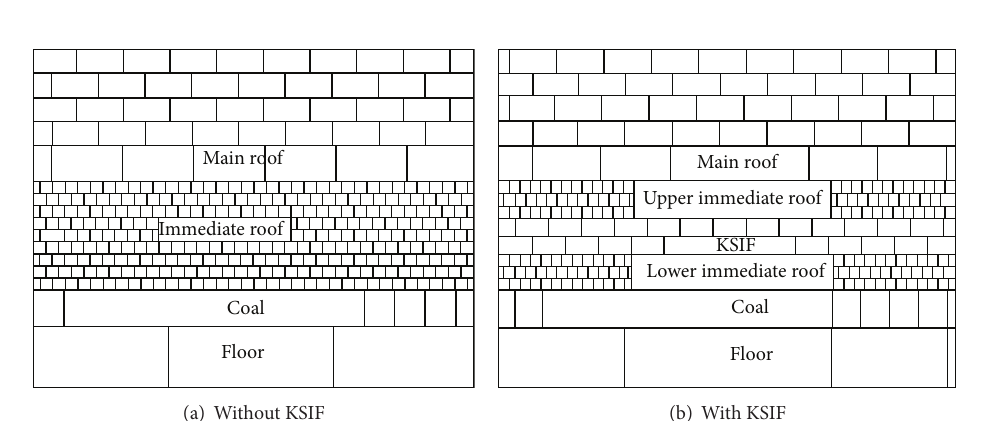
Figure 8: Simulation model of the exsitence of KSIR.